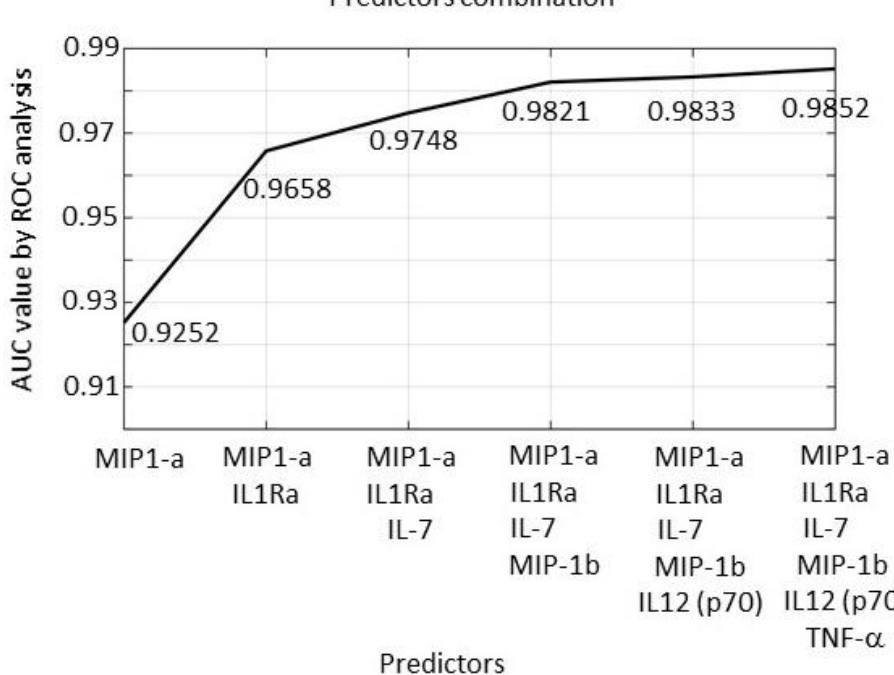
Figure 8. AUC values obtained by the SVM algorithm using one predictor ( MIP-1a ), two predictors ( MIP-1a + IL-1RA ), three predictors ( MIP-1a + IL-1RA + IL-7 ), four predictors ( MIP-1a + IL-1RA + IL-7 + MIP-1b ), etc., up to six predictors.